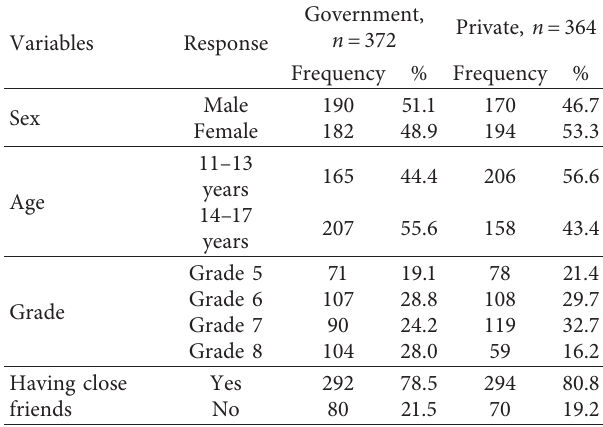
Table 2: Children’s sociodemographic characteristics among primary school students in Gondar town, 2019 ( n � 736).